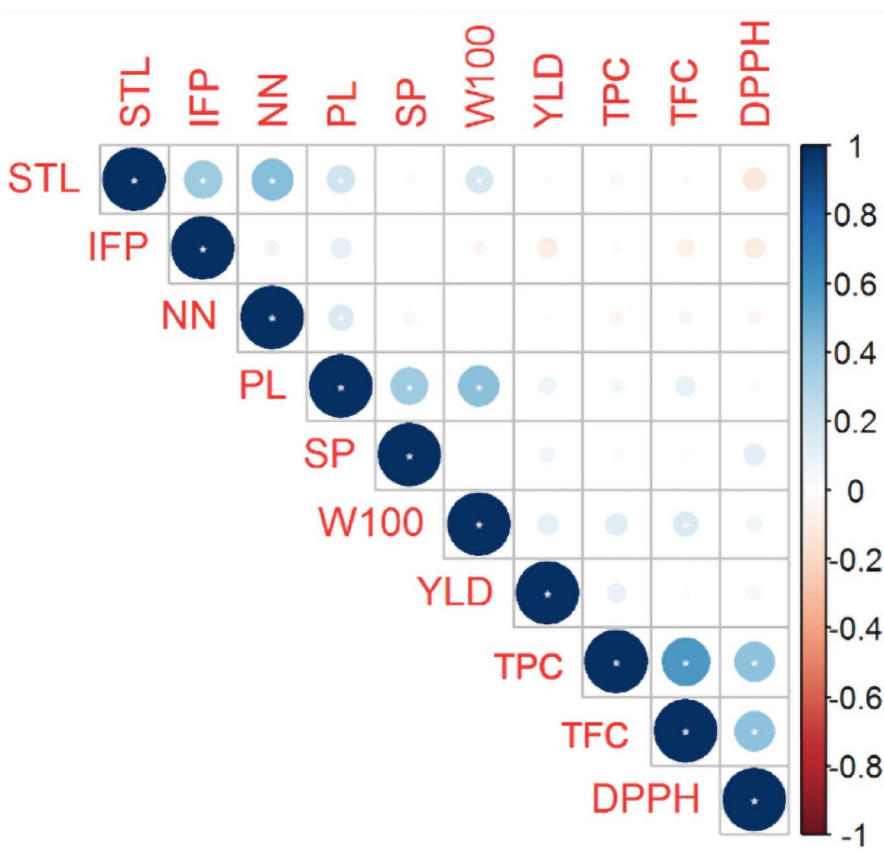
Fig 2. Correlation between the morpho-agronomic and biochemical traits of 215 Mesoamerican common bean accessions. STL: Main stem length, IFP: Insertion height of the first pod, NN: Number of nodes on main stem, PL: Pod length, SP: Number of seeds per pod, W100: Weight of 100 seeds, YLD: Seed yield, TPC: Total phenolic contents, TFC: Total flavonoid contents, and DPPH: Antioxidant capacity.